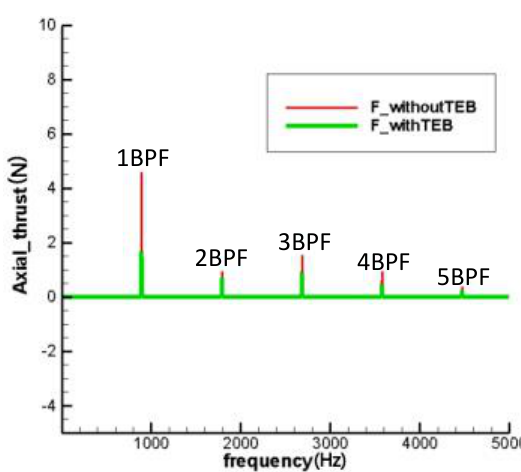
Figure 5. Axial thrust with and without nonuniform trailing edge blowing (NTEB).